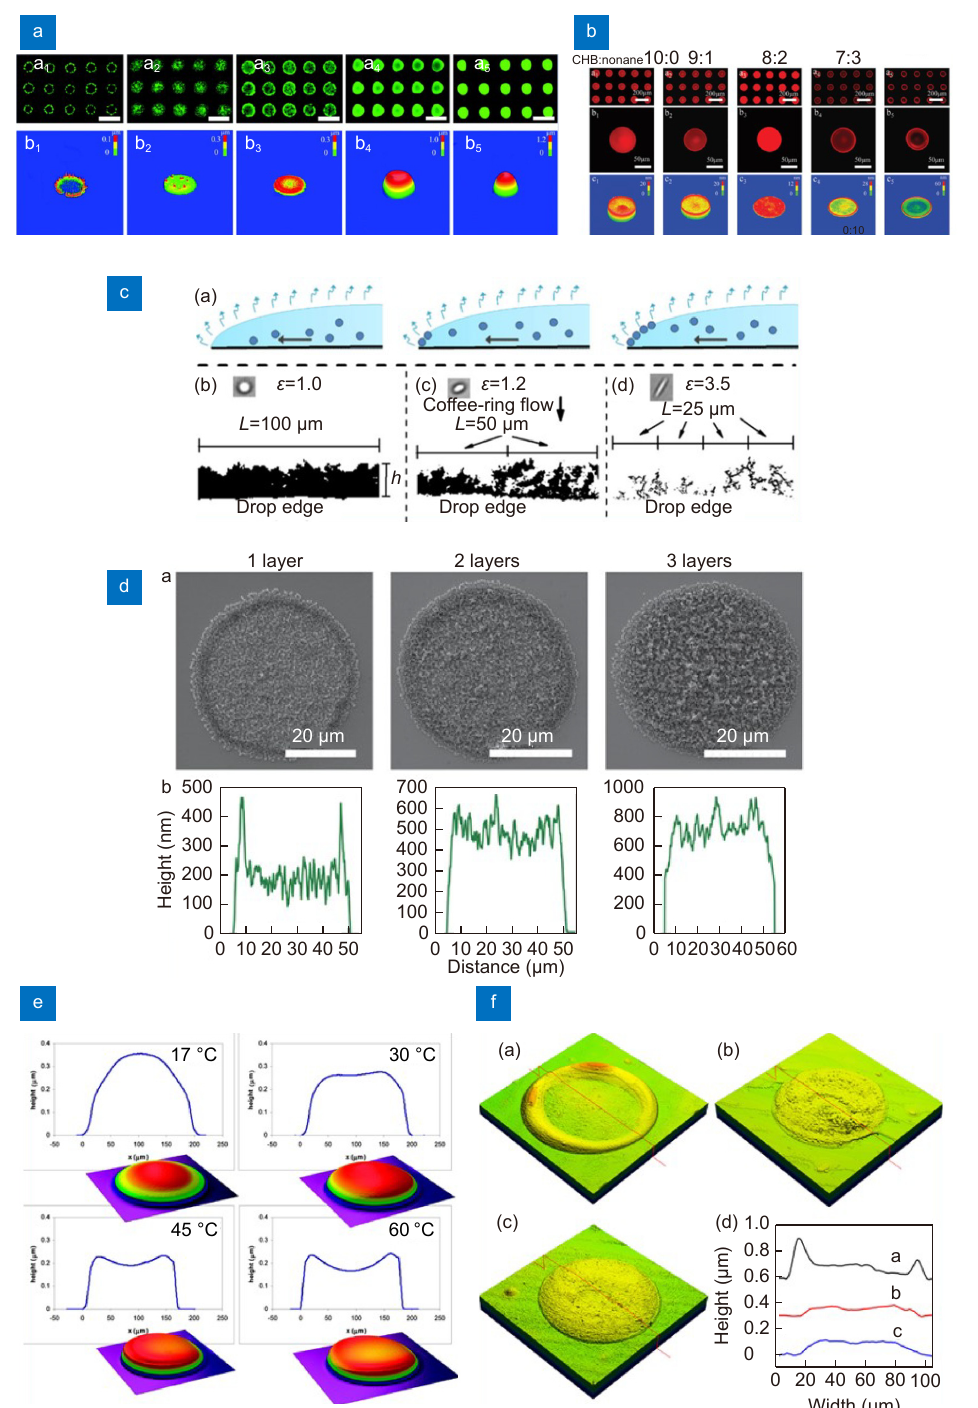
Fig. 12 | ( a ) Fluorescence microphotographs and three-dimensional white light interferometer images of dot arrays printed with different PVP concentrations. ( b ) Fluorescence microphotographs, higher resolution fluorescence microphotographs and 3D morphology images of the white light interferometer of QD dot arrays. ( c ) Illustration depicting deposition mechanism and binarized experimental images of deposits of spheres, slightly stretched particles and ellipsoids. ( d ) SEM images of polystyrene ink drops printed in one, two, and three layers; AFM profile of deposited drops of PS 450. ( e ) Cross section and 3D projection from an optical profilometer of single drops at different temperatures. ( f ) Confocal laser scattering microscopic 3D images of dots with varying solvent compositions and corresponding two-dimensional profiles. Figure reproduced with permission from: (a) ref. 112 , The Royal Society of Chemistry; (b) ref. 71 , John Wiley and Sons; (c) ref. 126 , American Physical Society; (d) ref. 127 , John Wiley and Sons; (e) ref. 128 , American Chemical Society; (f) ref. 129 , AIP